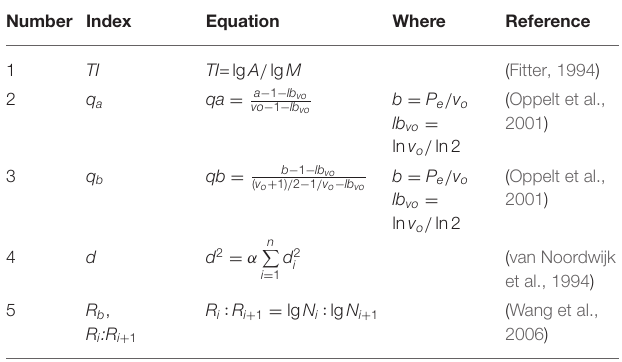
TABLE 2 | Equations for calculating the RSA (root system